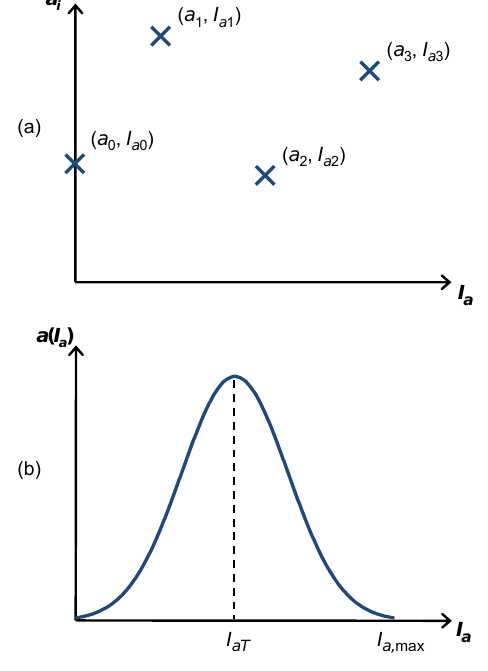
Figure 5. Representing areal distribution of I a within a watershed (a) discrete case and (b) continuous